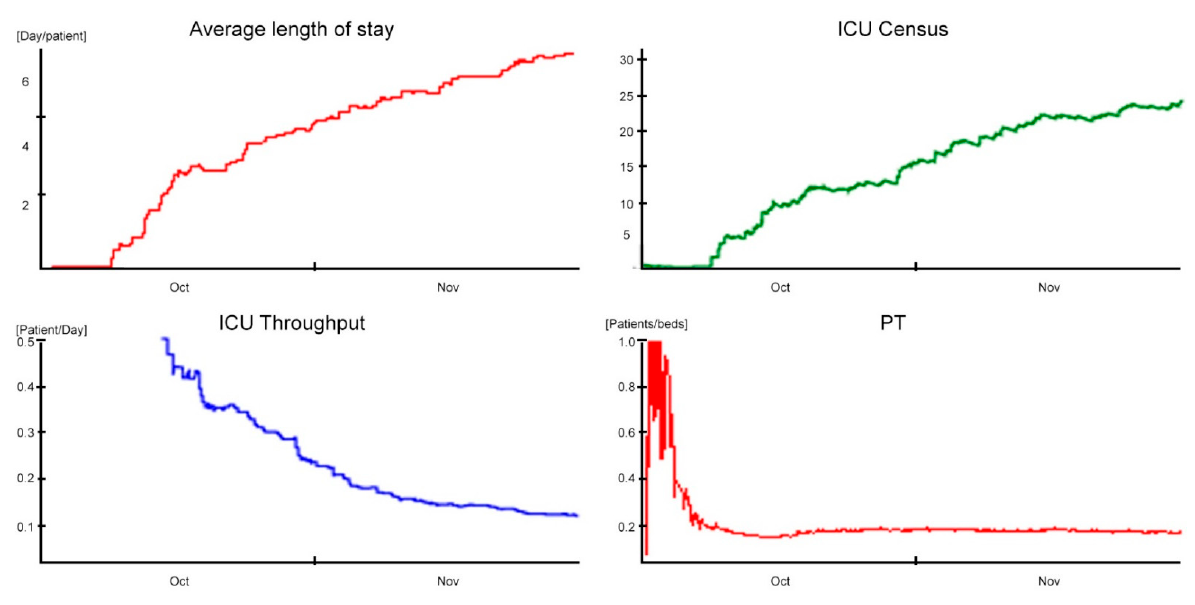
Figure 7. Outcomes in post-hospitalization buffer scenario.